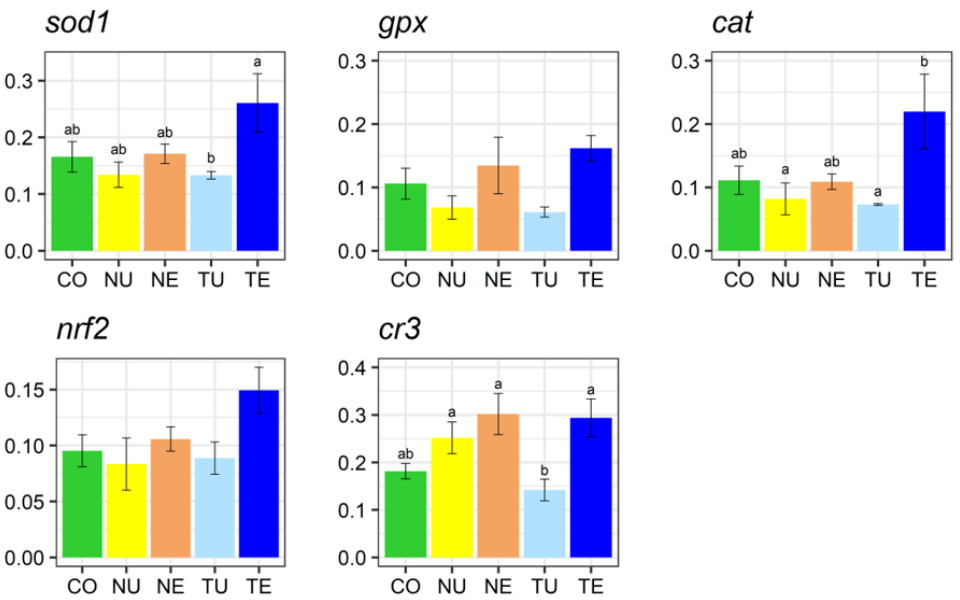
Figure 3 Figure 3. Relative expression of antioxidant and immune-related genes. Shown are the expression of sod1 , gpx , cat , nrf2 and cr3 in the liver of Atlantic salmon fed on different diets (CO, NU, NE, TU, TE) (n = 4 per diet). Different letters (a, b) above the bars indicate significant differences ( p <